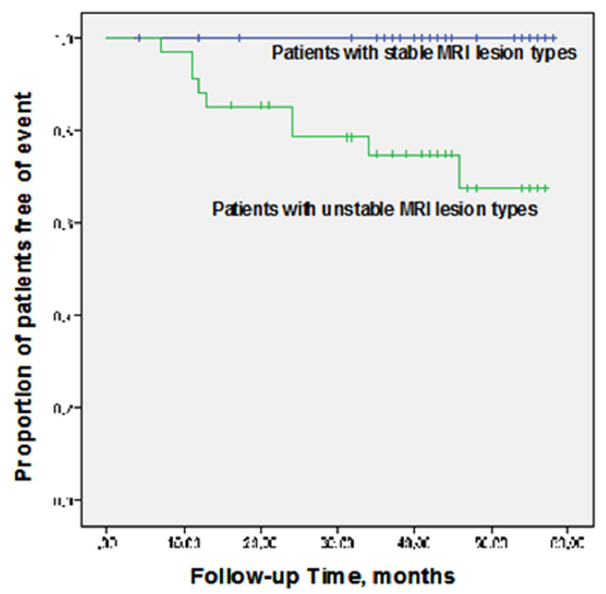
Figure 3. Kaplan–Meier curves. Kaplan–Meier survival estimates of the proportion of patients free of ipsilateral cerebrovascular events for patients presenting with stable MRI lesion types (upper curve) and with unstable MRI lesion types (lower curve). Event-free survival was higher among patients with the MRI-defined stable lesion types (III, VII, and VIII) than in patients with the MRI-defined high-risk lesion types (IV–V and VI) (log rank test P , 0.0001).